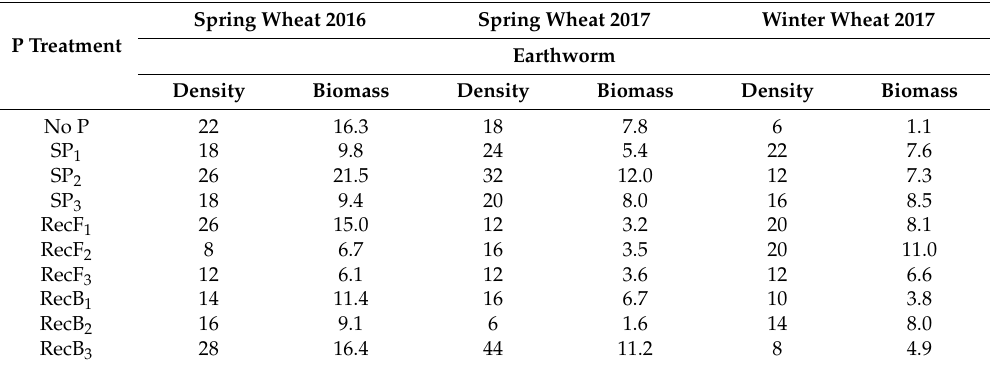
Table 6. Earthworm density (no. m − 2 ) and biomass (g m − 2 ) in the 0–0.4 m layer of soil under wheat (averages from four replications /